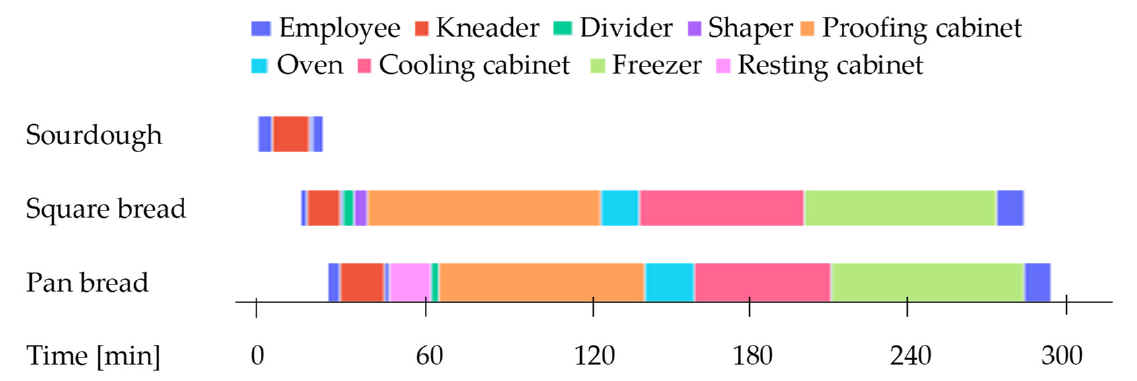
Figure 4. Example schedule of three products with a production sequence of {sourdough, square bread, pan bread}.